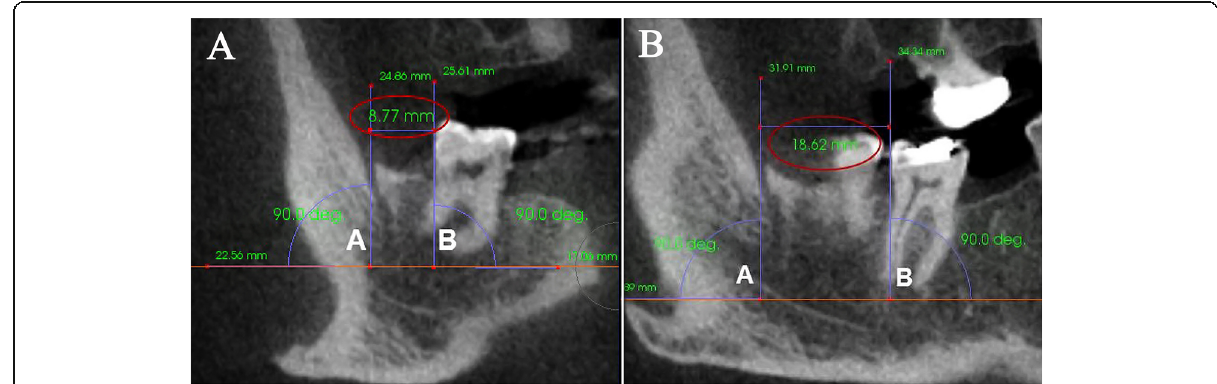
Fig. 2 Linear measurements between the RMF and the 2nd and 3rd molars in anteroposterior direction. a Sagittal cut: “ A ” is the line from the RMF perpendicular to the axial plane reference line, “ B ” is the line tangent to the 3rd molar distal surface and perpendicular to the axial plane reference line, and the linear measurement between the RMF and distal surface of the 3rd molar is 8.77 mm. b Sagittal cut: “ A ” is the line from the RMF perpendicular to the axial plane reference line, “ B ” is the line tangent to the 2nd molar distal surface and perpendicular to the axial plane reference line, and the linear measurement between the RMF and distal surface of the 2nd molar is 18.62mm